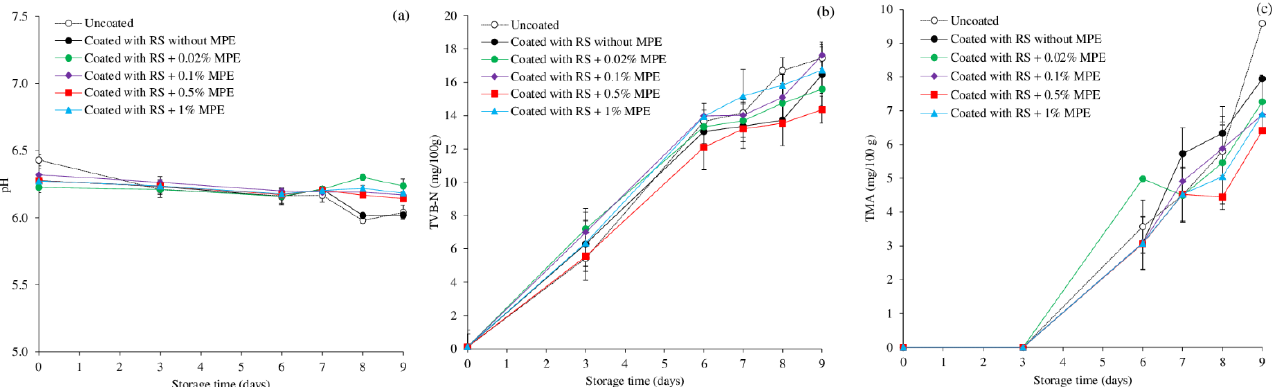
Figure 5. Changes in pH ( a ), total volatile base-nitrogen (TVB-N) ( b ), and trimethylamine content (TMA) ( c ) of mackerel slices over the course of storage at 4 °C as influenced by coating with rice starch (RS) containing Mon-pu extract (MPE) at different concentrations. Bars represent standard deviation from triplicate determinations.